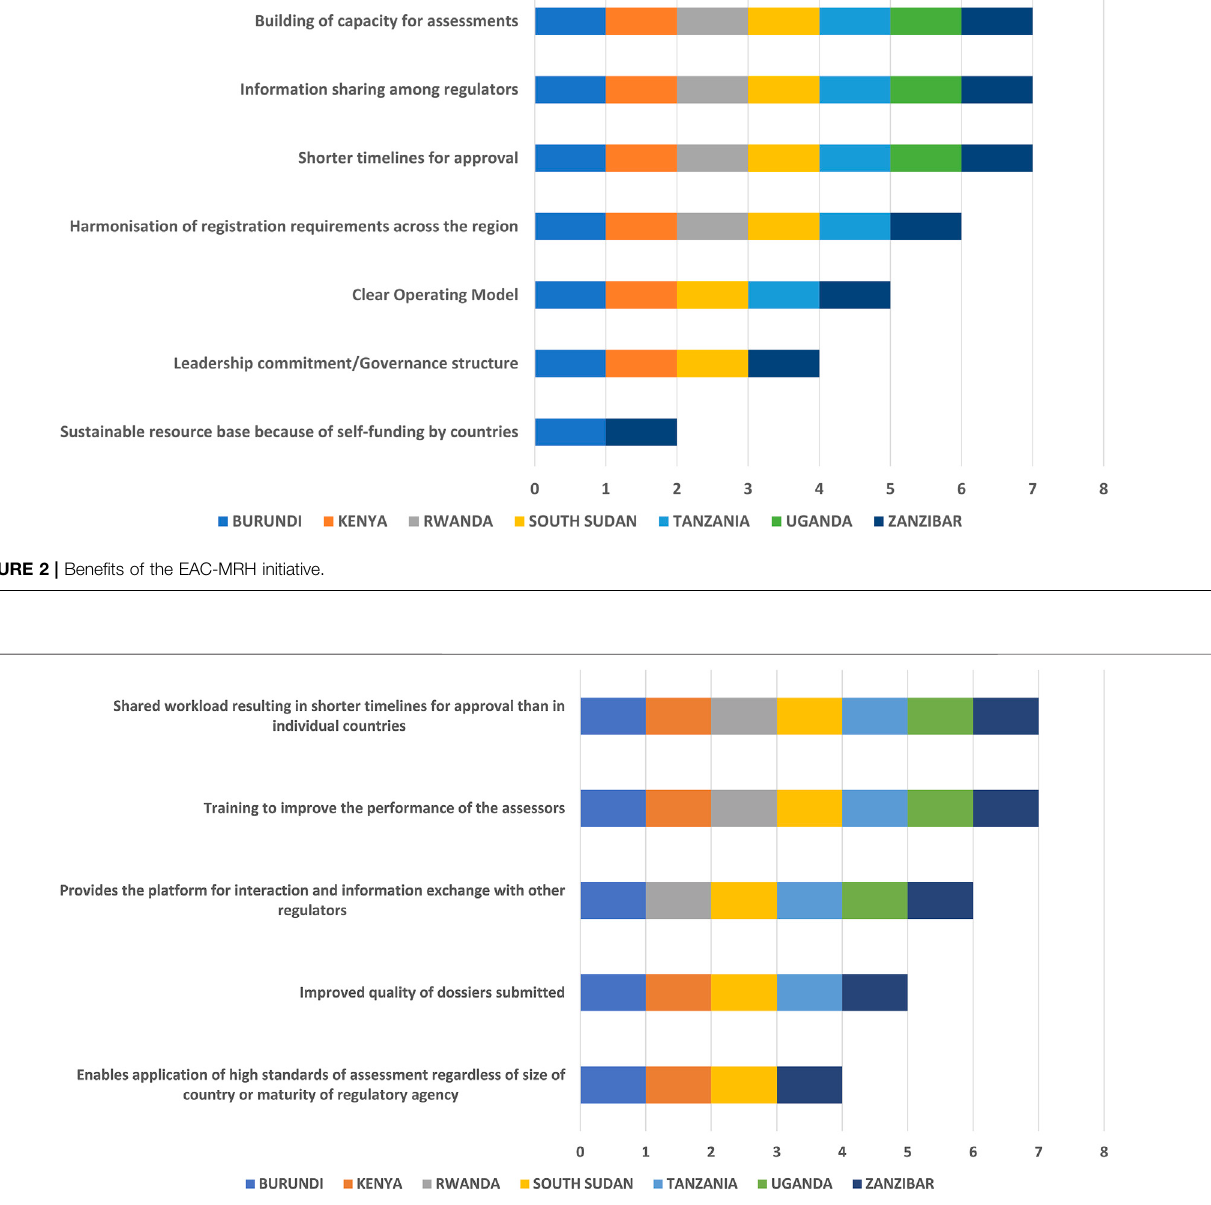
Frontiers in Pharmacology |